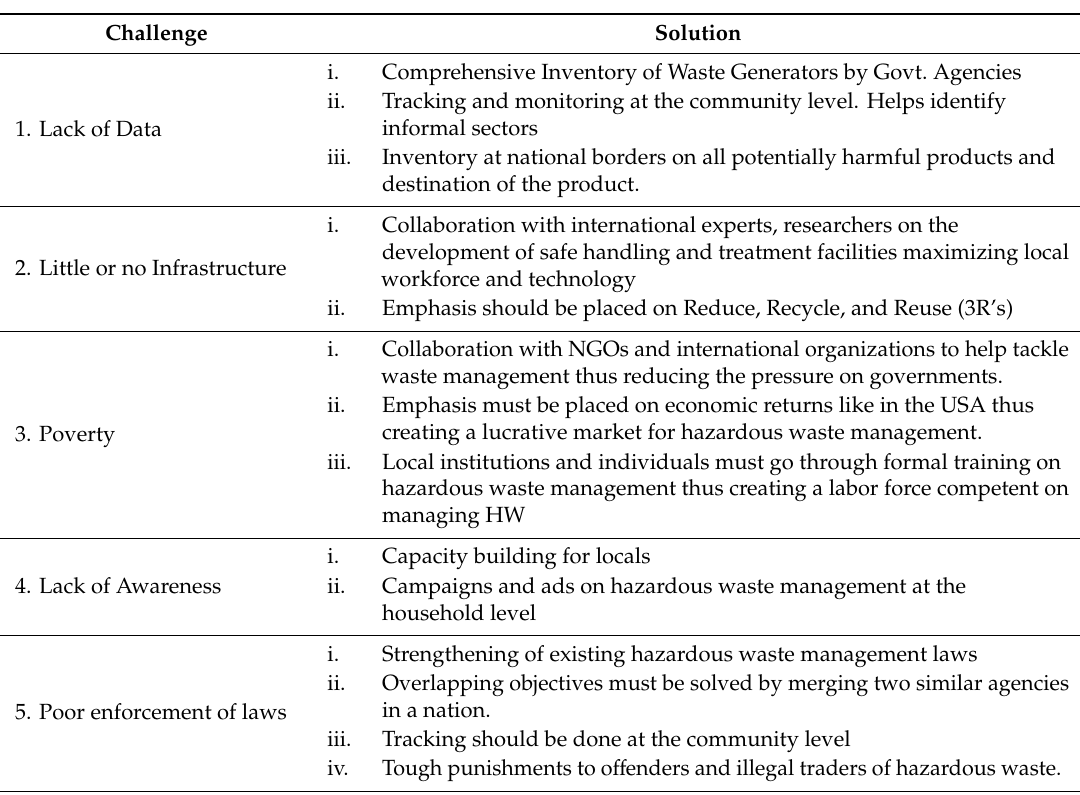
Table 7. Challenges and solutions for decision making